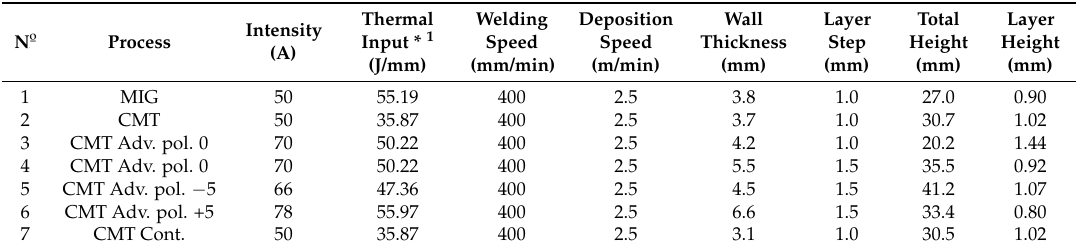
Table 3. Definition of parameters used for each sample and results.